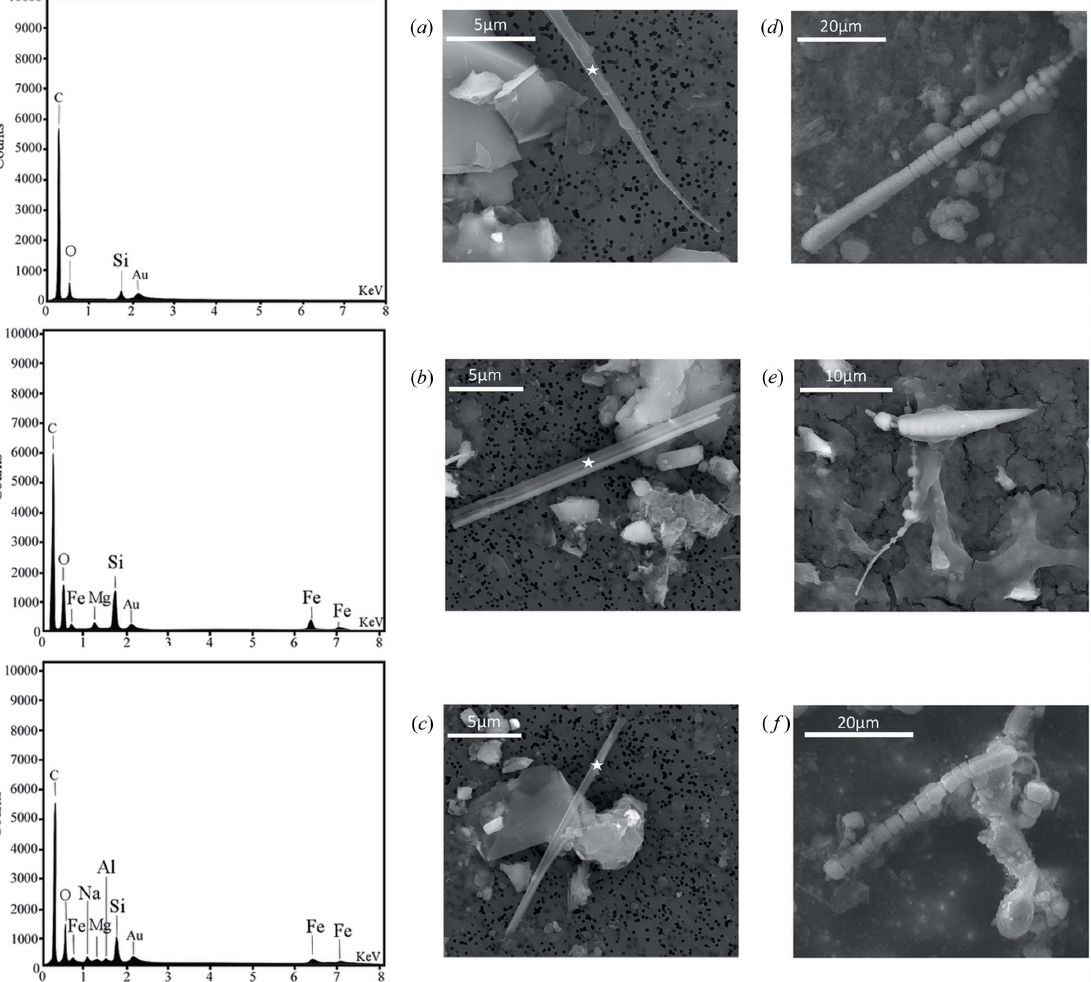
Figure 1 A gallery of acquired FEG-SEM pictures and EDX point spectra of uncoated and coated fibres found in the lung tissues of the male subject. ( a ) The metastable product of the dissolution of chrysotile. The EDX spot analysis (shown at the top left) indicates that the fibre is only composed of SiO 2 . ( b ) Amosite fibre with the corresponding EDX spectrum on the left showing the bands assigned to the three more abundant elements of amosite, i.e. Mg, Si and Fe. ( c ) Crocidolite fibre with the corresponding EDX spectrum (at the bottom left) showing the presence of Na in addition to Fe, Si and Al. Au is from the sample coating. The observed ABs exhibit multiform shapes. Forms: ( d ) lancet-like, ( e ) beaded/dagger-like and ( f ) beaded/cylindrical-like